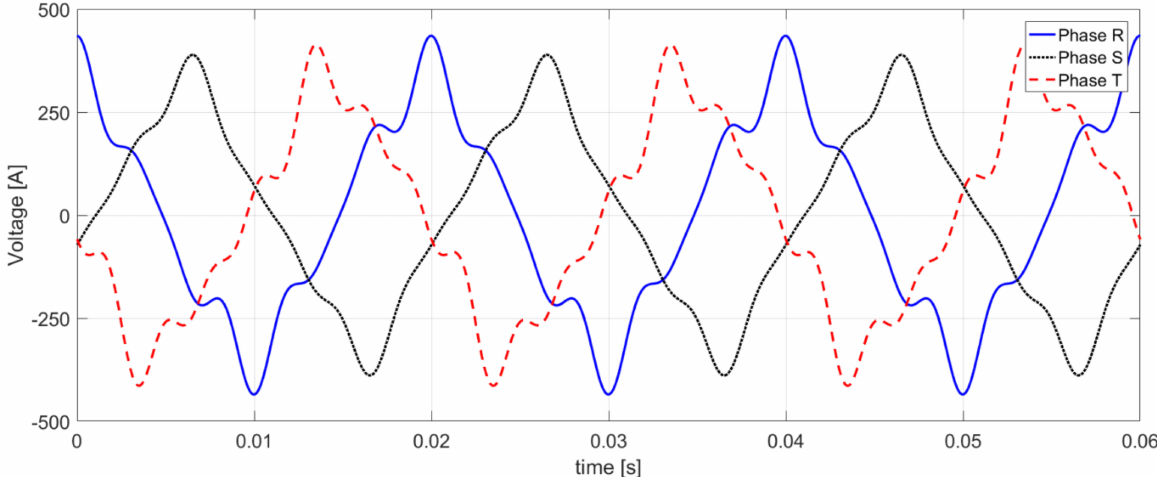
Figure 3. The three-phase voltage waveforms at the terminals of the